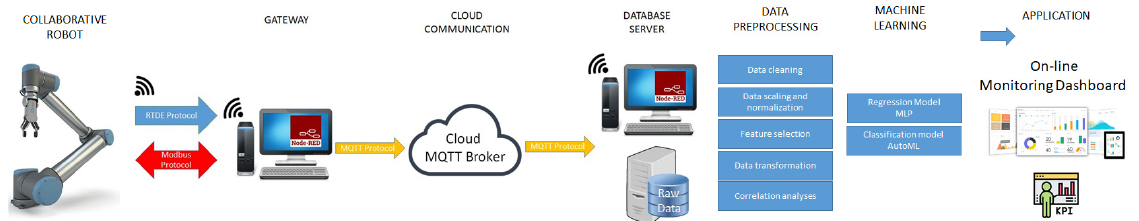
Figure 2. On-line monitoring